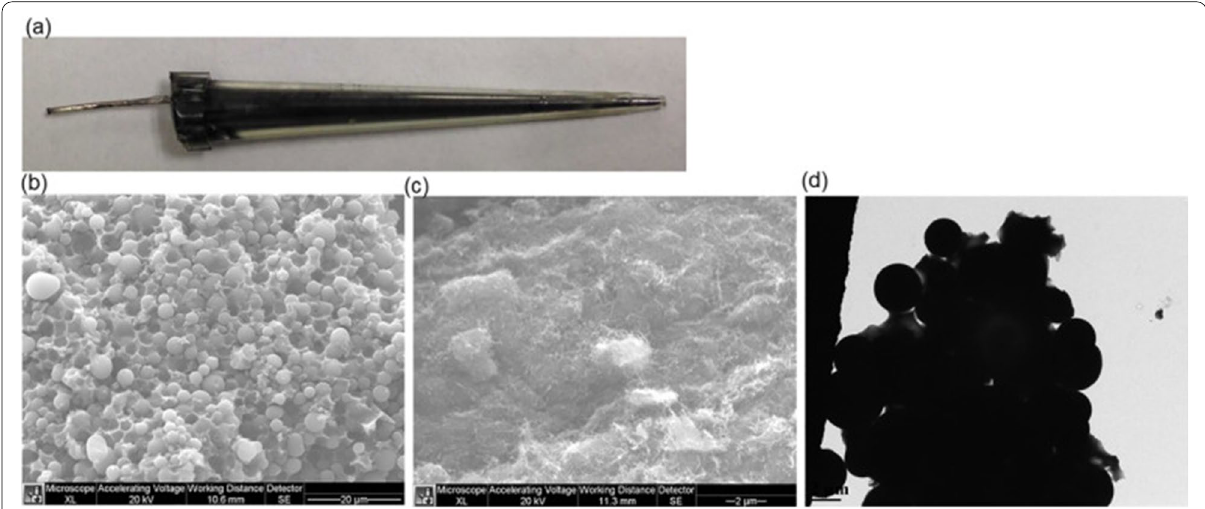
Fig. 3 a Optical image of a carbon beads-based sensor. b SEM (scanning electron microscope) images of carbon beads-based sensor. c CNT (carbon nanotube)-based sensor. d TEM (transmission electron microscope) image of carbon beads based sensor. Taken from (Zhang et al. 2019) with permission from Elsevier (Copyright